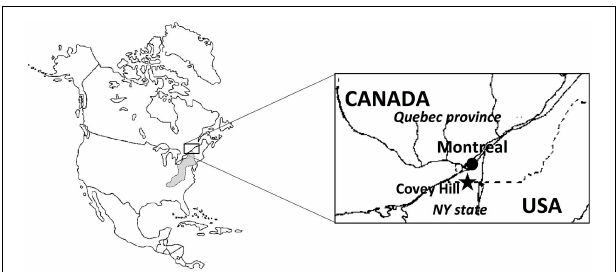
FIGURE 1 | Location of the study site in the Covey Hill area. The hill is on the northern edge of the putative distribution of the Allegheny Mountain Dusky Salamander (shaded